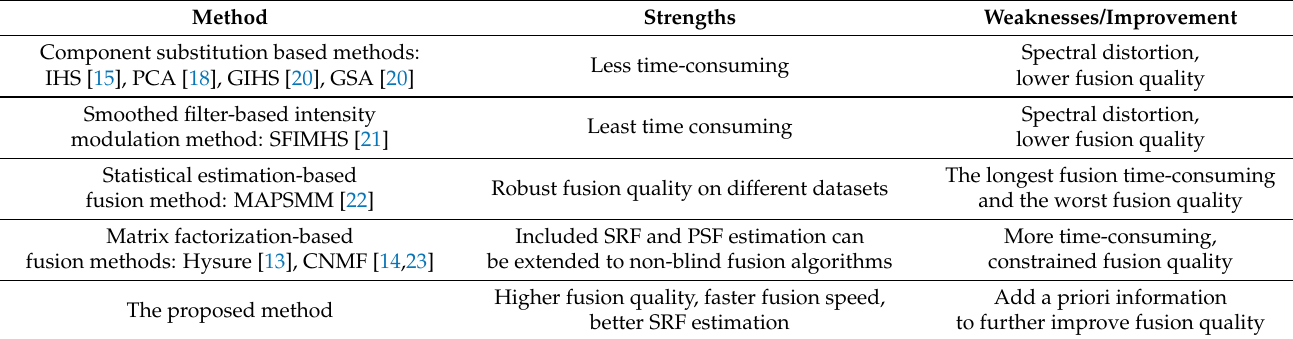
Table 1. Summary of the strengths and weaknesses of related